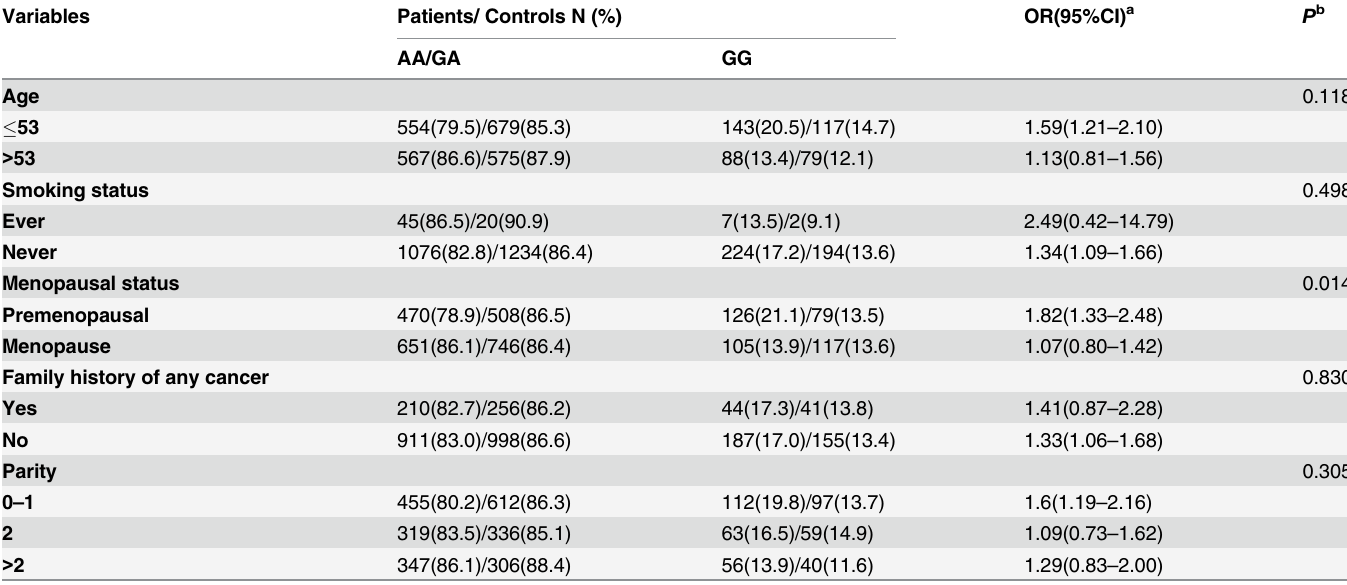
Table 6. Stratified analyses on association between rs7248320 genotypes and cervical cancer